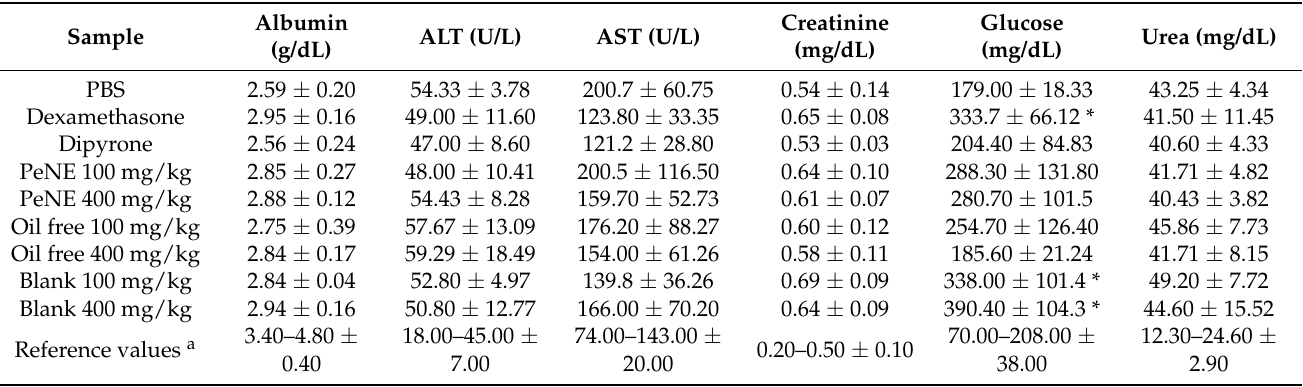
Table 2. Biochemical analysis from the blood samples of rats after oral treatment with PeNE or free pequi oil for 15 days.